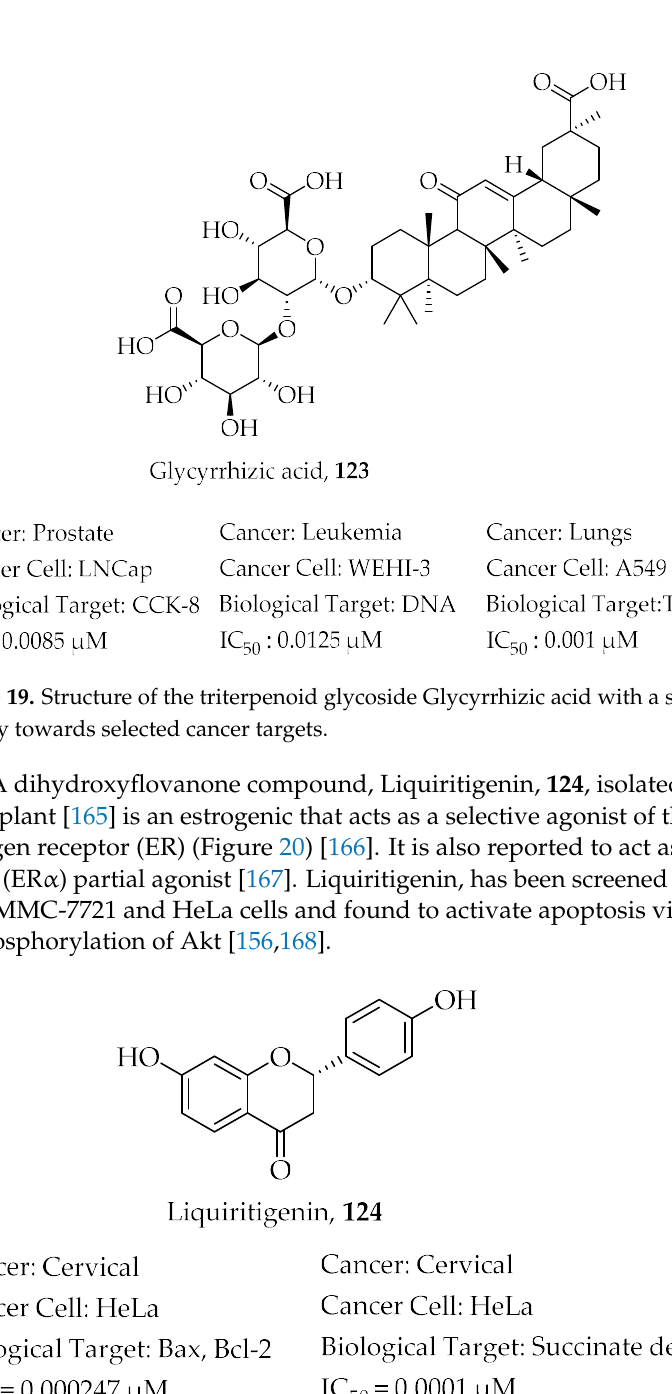
Figure 18. Structures of acetogenins 104 – 106 , sesquiterpene lactones, 107 – 111 and compounds isolated from Eclipta pros- trata 113 – 117 .